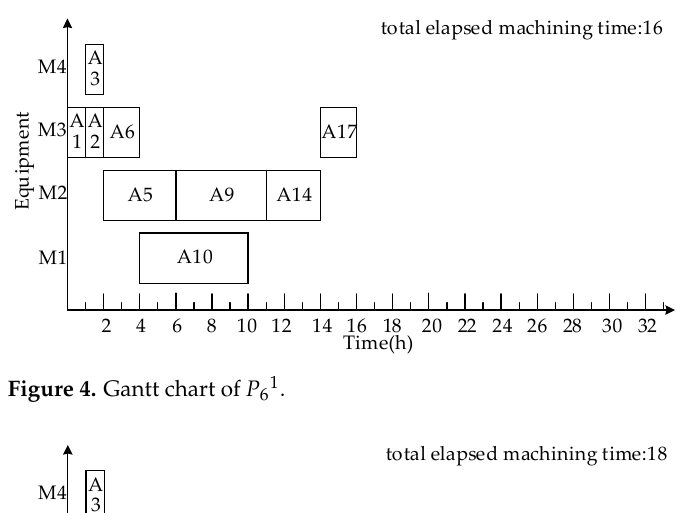
Figure 3. Gantt chart of P 5 .